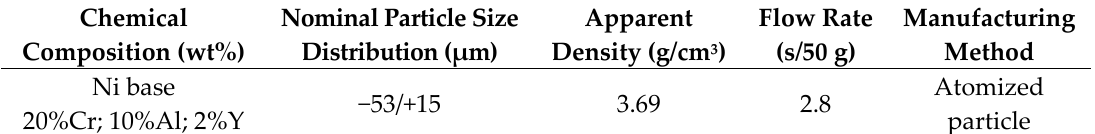
Table 3. Physical characteristics of the powder